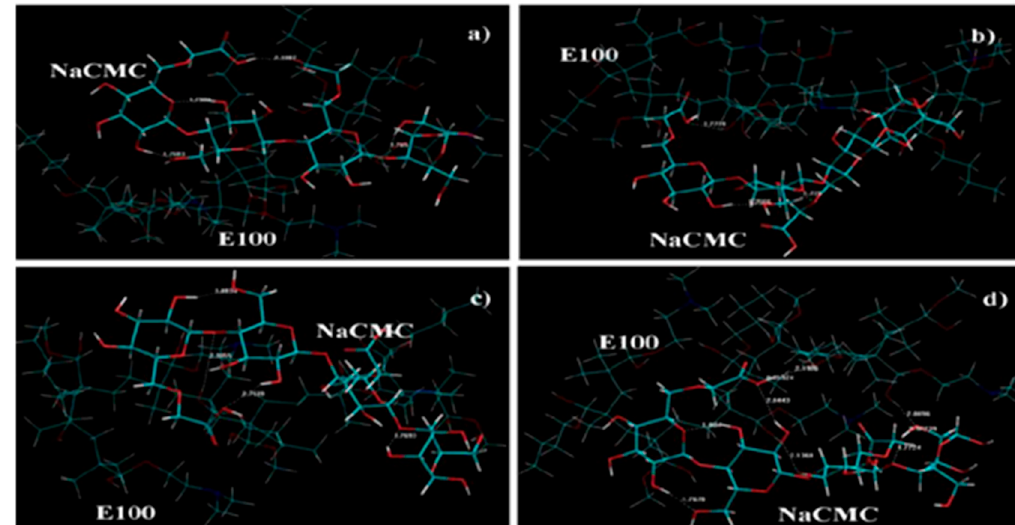
Figure 6. Molecular mechanic simulations of the synthetic process of NaCMC/E100 IPEC. ( a ) initial stage of mixing, ( b ) after 1 h, ( c ) breaking point, ( d ) final formation of the IPEC (Adapted with permission from [122], MDPI, 2013.)